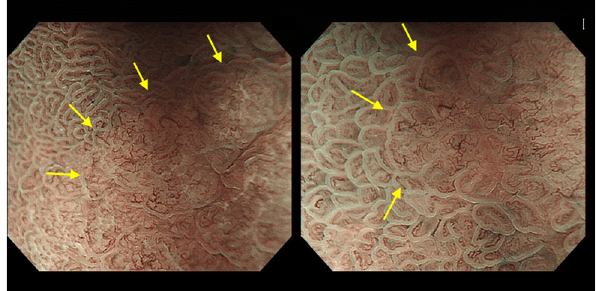
Figure 2. Cancerous lesion: Within a DL (arrows), irregular MVP and irregular MSP are noted.